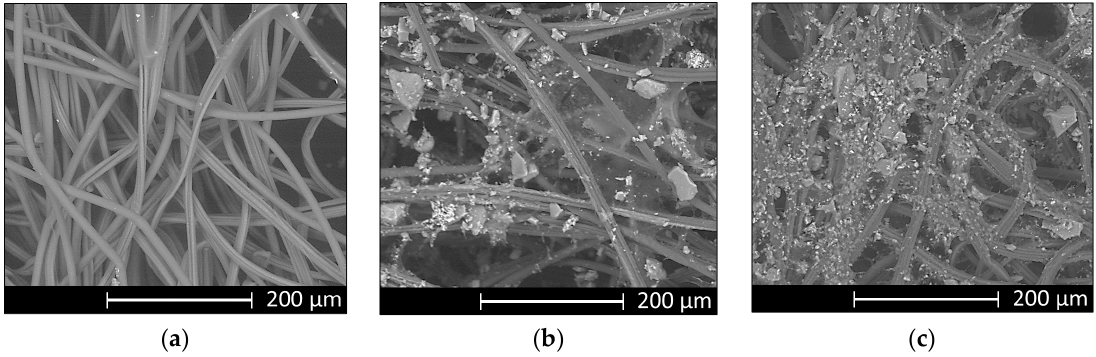
Figure 1. SEM images of microstructure of wound dressings: Chitosan (CHT) ( a ), CHTSrMg5 ( b ), and CHTSrMg10 ( c ), before soaking in simulated body fluid (SBF) solution.